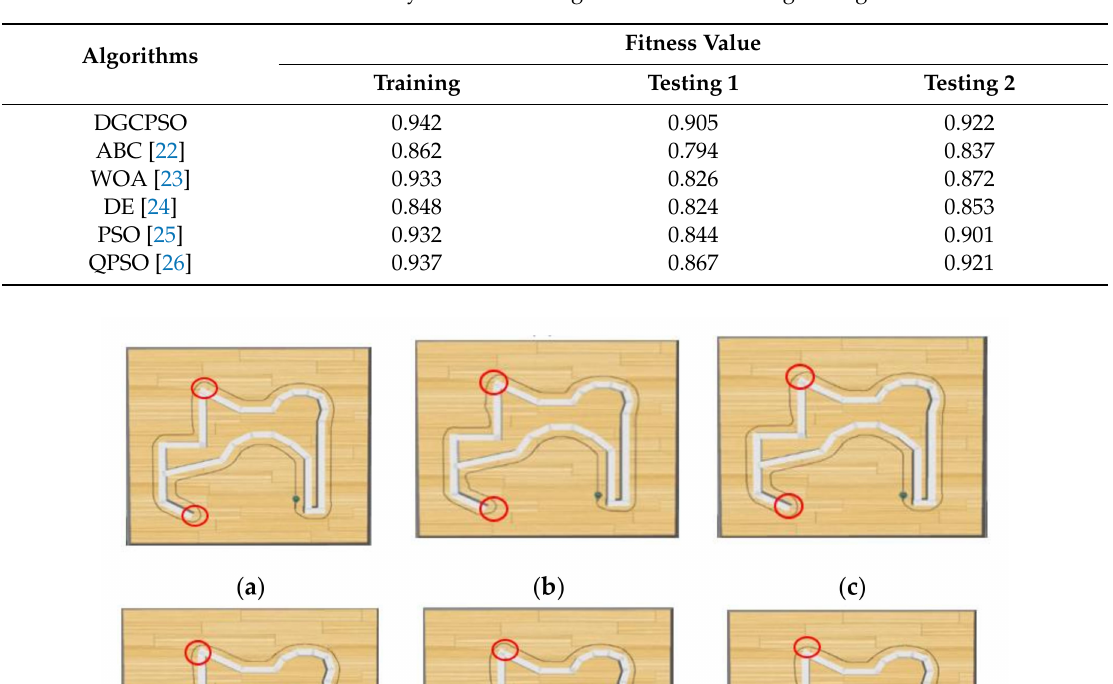
Table 7. E ffi ciency of di ff erence algorithms in the testing setting.